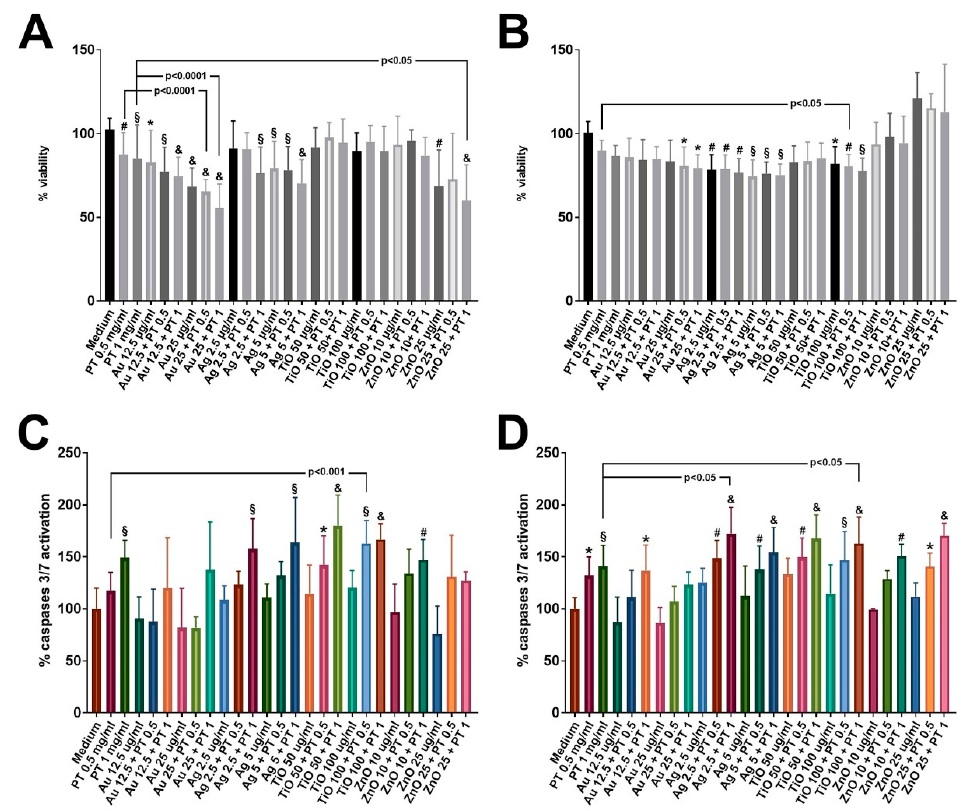
Figure 3. MTT and Caspase 3/7 activation assays. Data are expressed as percentage of untreated cells (Medium). Significance versus untreated cells is indicated above each column (* p < 0.05; # p < 0.01; § p < 0.001; & p < 0.0001), whereas versus PT is represented by bars. ( A ) MTT on undifferentiated cells; ( B ) MTT on post-confluent cells; ( C ) apoptosis assay on undifferentiated cells; ( D ) apoptosis assay on post-confluent cells. Data are shown as mean value and SD ( n =